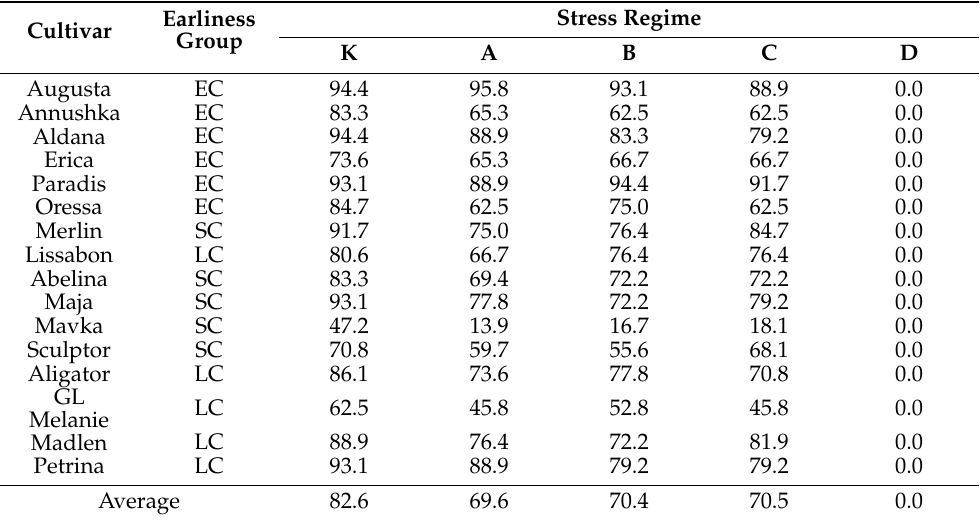
Table 1. Seedling emergence (%) after 10 days depending on stress regime and cultivar (n = 36).